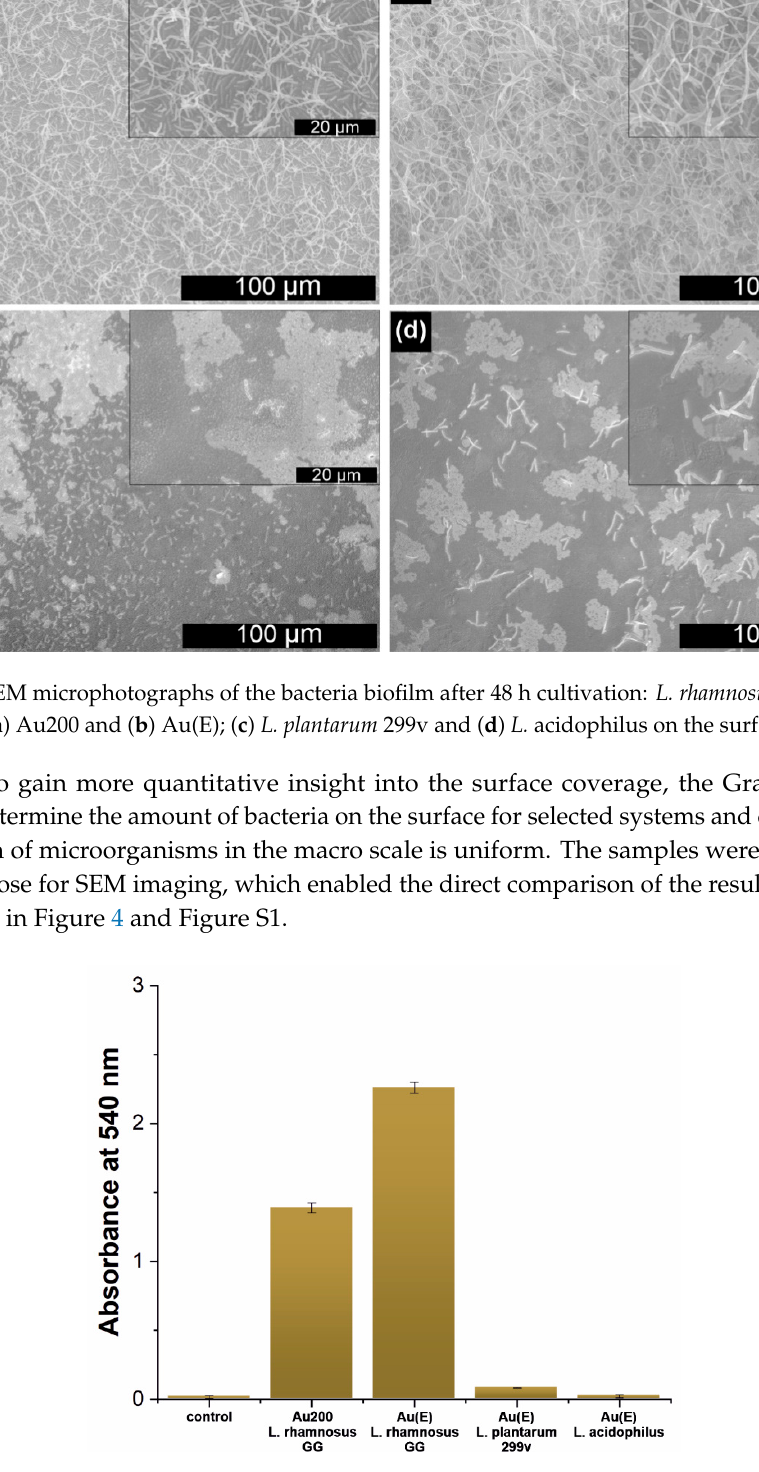
Figure 4. The absorbance of the crystal violet from the gold substrates after inoculation with Lactobacilli strains and corresponding photographs of the stained samples.